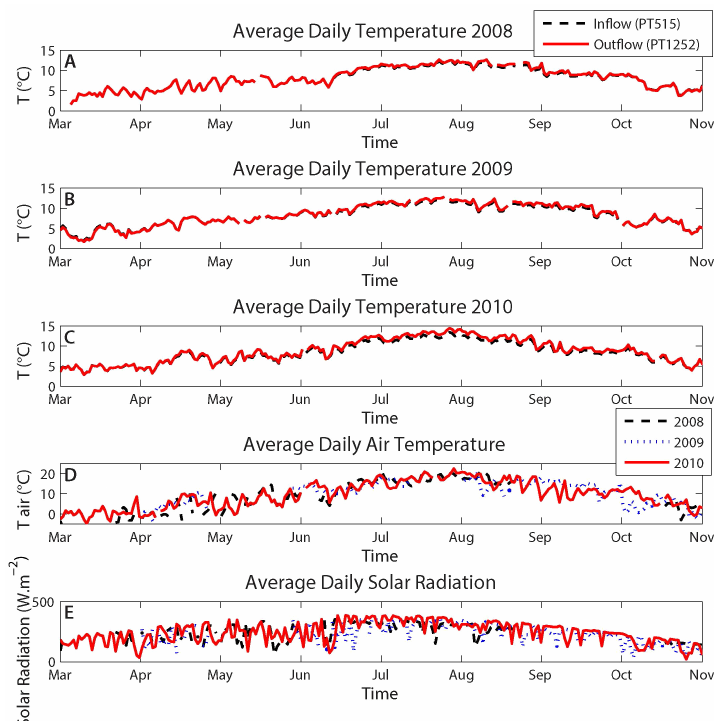
Figure 4. Average daily temperature (absolute) representing reach-scale responses at inflow (PT515, black-dashed line) and outflow (PT1252, red-solid line) during (a) 2008, (b) 2009, and (c) 2010. (d) Average daily air temperature and (e) average daily solar radiation show similar weather patterns for all three